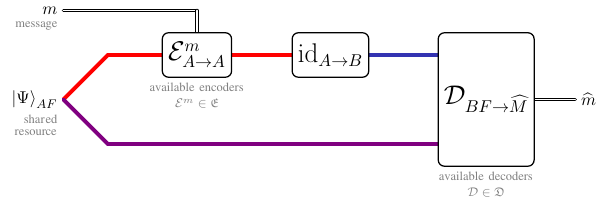
FIG. 2. A dense coding protocol for the shared resourceful quantum state (cid:2) AF under the available encoder-decoder pair ( E , D ) . In this protocol, Alice possesses system A (red line), Bob possesses system B (blue line), and Fred possesses system F (purple